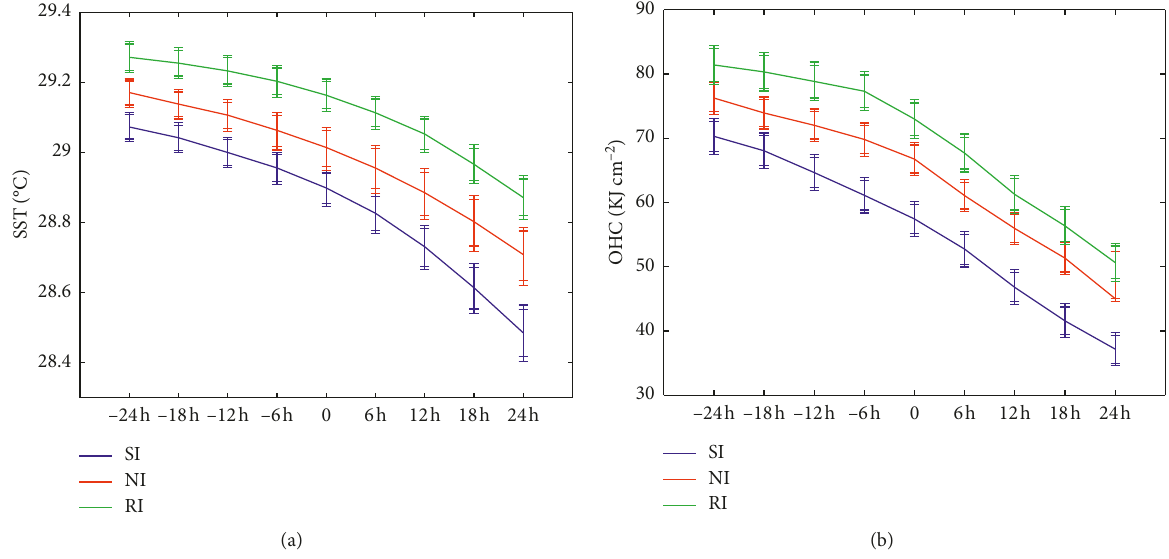
Figure 13: As in Figure 7, but for (a) SST ( ° C) and (b) OHC (kJ cm − 2 Figure 15. First, the occurrence of RI is rarer than NI and SI for all SST. The occurrence probability of RI increases when the SST is above 27 ° C (Figure 15(a)). The occurrence probability of SI decreases with an increasing SST, whereas the occurrence probability of NI does not vary with the SST.